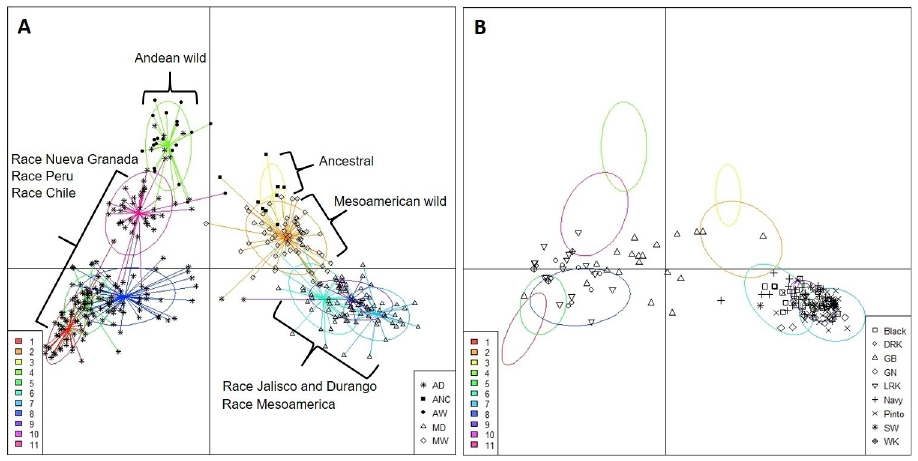
Fig 5. A. Results of DAPC applied to a worldwide germplasm collection of 349 wild and domesticated landraces of common beans [7]. B. Scatterplot of the projection of the 192 common bean advanced cultivars on the genetic clusters identified by DAPC on the worldwide germplasm collection. The clusters are represented by their inertia ellipses.